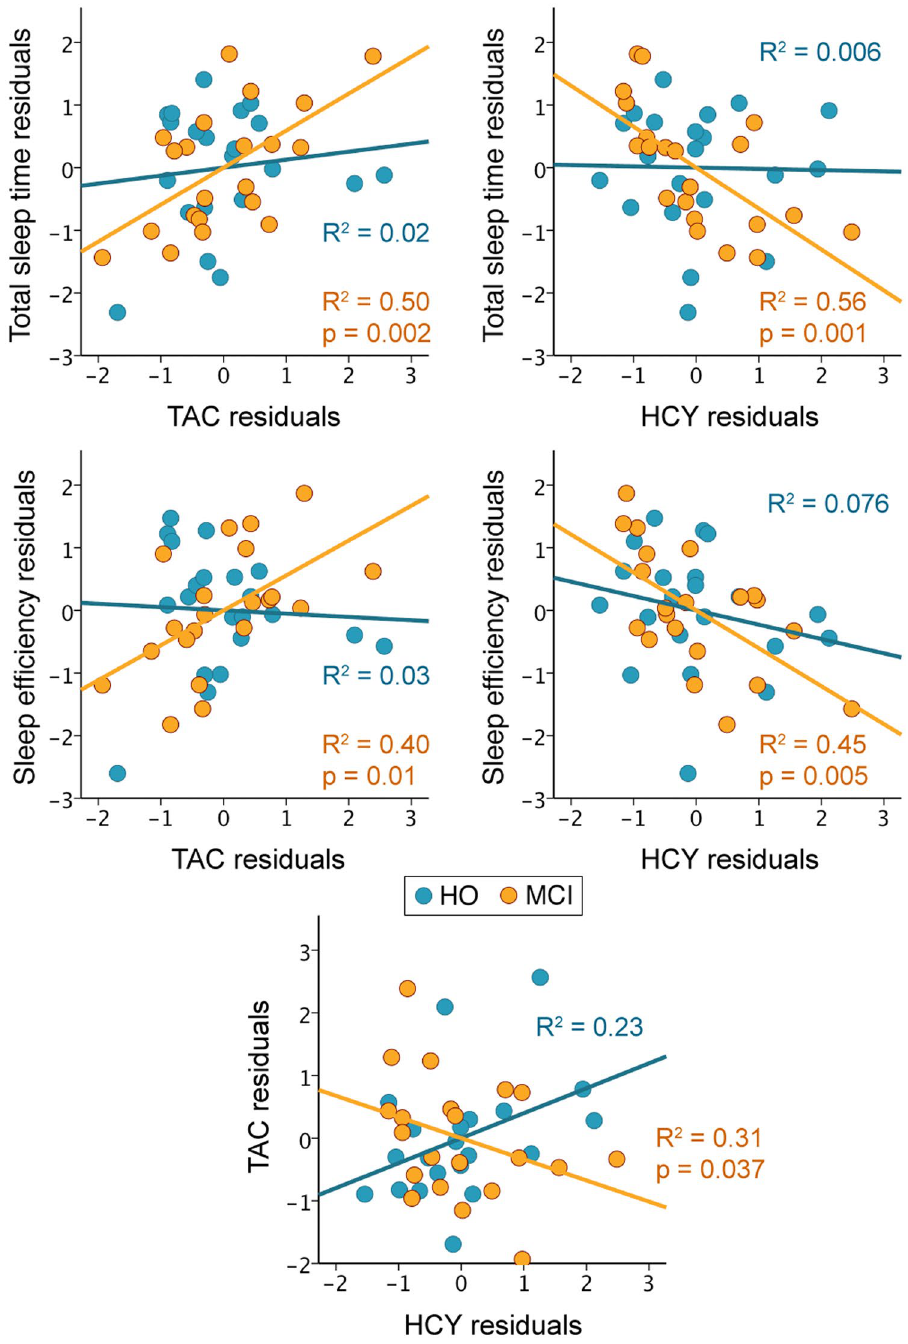
Figure 1. Correlations between TAC, HCY, and sleep. Scatter plots of TAC/HCY against total sleep time/sleep efficiency for HO (in blue) and MCI (in orange). The variables included in the scatter plots correspond to the standardized residuals from a simple regression with age as independent variable. The relationship between HCY and TAC residuals is shown in the bottom panel. The coefficients of determination (R2) and probability (p value) for each group are also